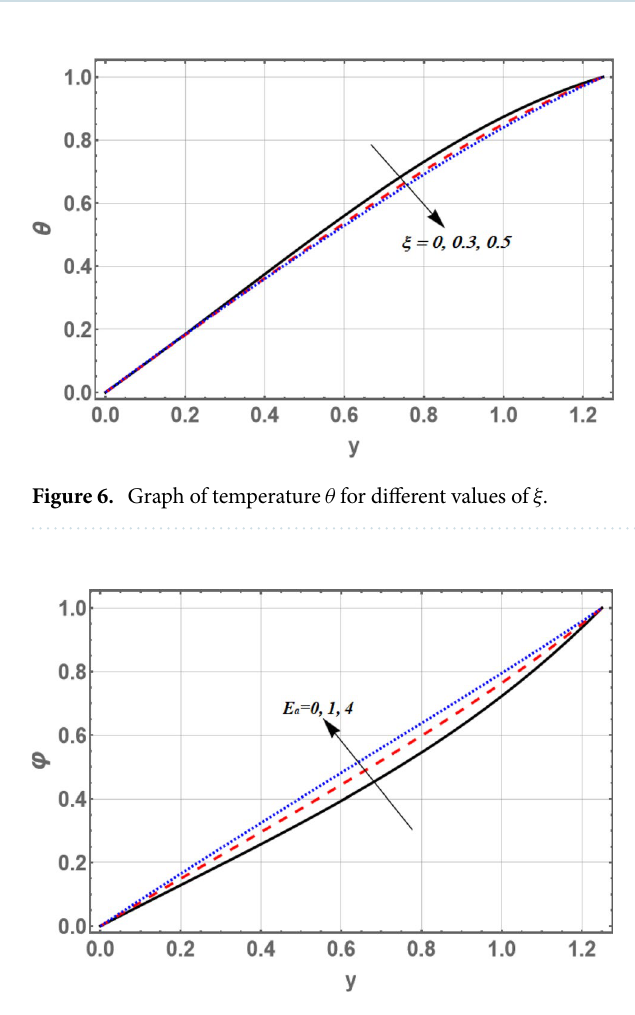
Figure 7. Graph of concentration ϕ for different values of E a .